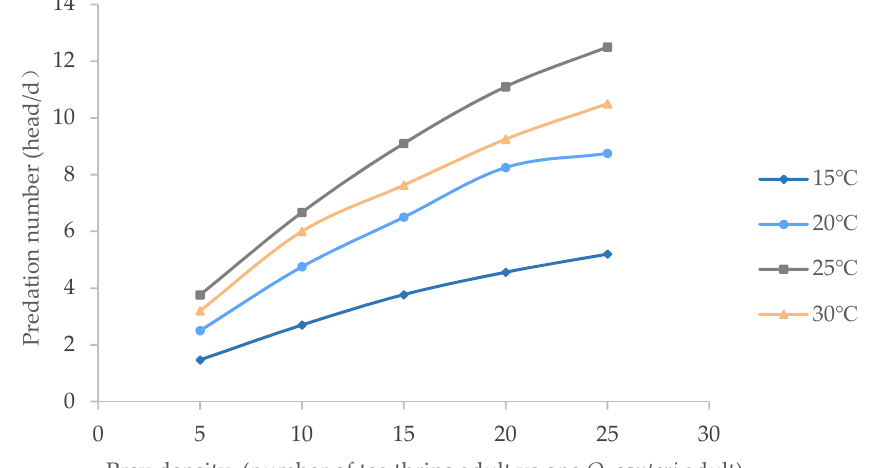
Figure 2. Predatory functional responses of O. sauteri adults on adult tea thrips at different temper- atures.